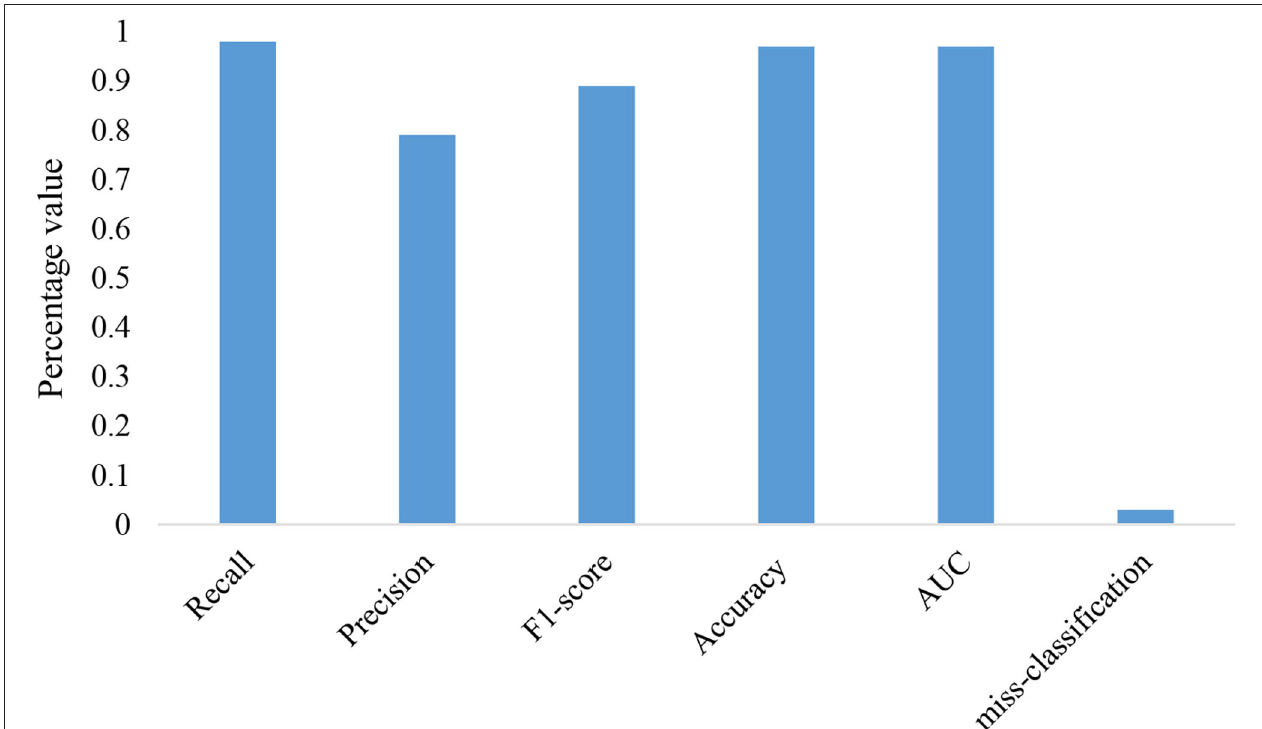
FIGURE 8 | Evolution of the proposed research